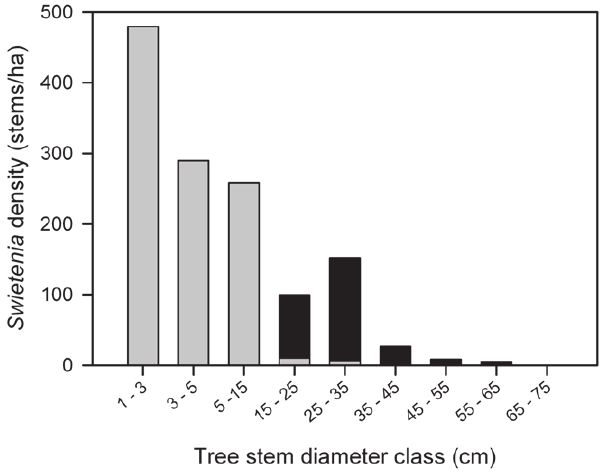
Figure 2. Histogram showing the size-class distribution of introduced mahogany ( Swietenia ) in Cabrits National Park, Dominica. Trees $ 20 cm dbh were sampled in planting zones ( n =137 trees: 127 S. macrophylla + 10 S. mahagoni ) and stems $ 1 cm dbh ( n =285) were sampled in a network of small 37 circular plots (see Appendix S1). In the latter, 15 stems . 20 cm dbh were also found most of which were from plots in the planting zones (Appendix S1). To standardize sampling effort, derived counts for each sampling scheme are expressed here on a per hectare basis. The black bars indicate size- classes or portions thereof that most likely originated through planting efforts in 1960’s to early 1970’s, whereas gray bars indicate natural regeneration inferred from the pattern of planting. The latter includes four trees in the 15–25 cm dbh class found in plots outside planting zones, as well as four ‘X’ trees (22.6, 28.4, 29.9 and 30.5 cm dbh) found in our general survey of planting zones (see Appendix S1).